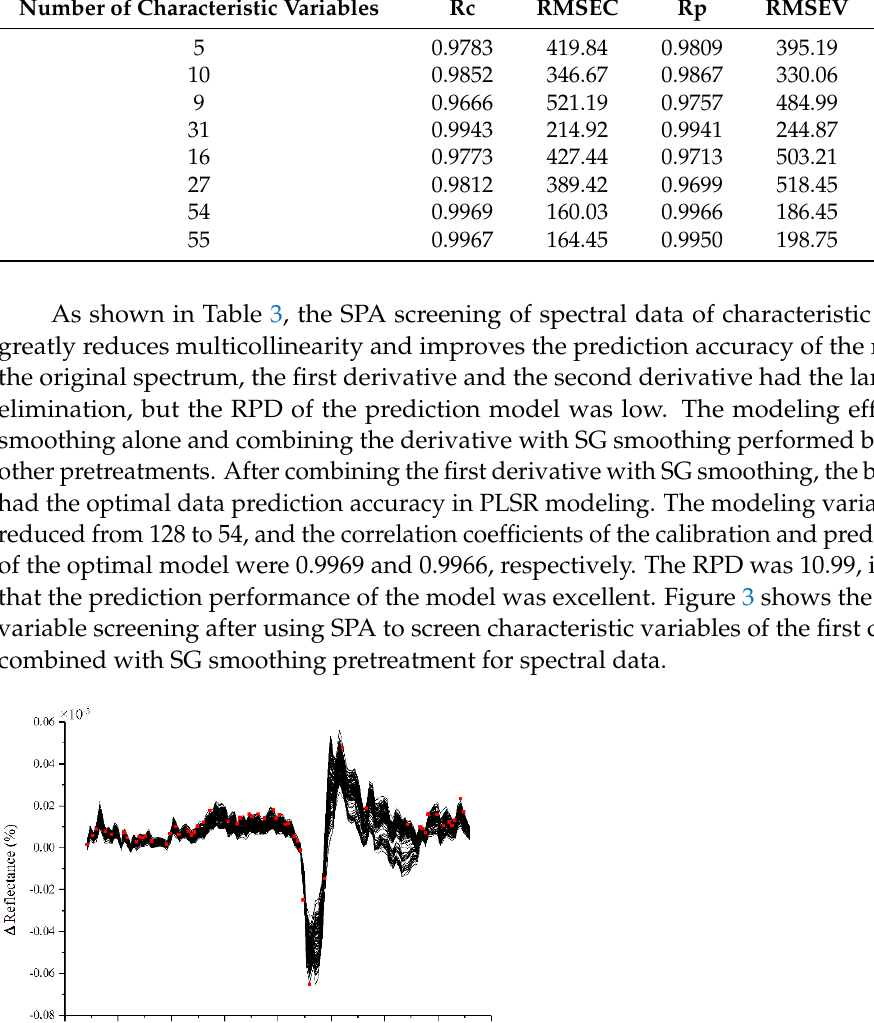
Table 4. Comparing PLSR results after extracting spectral features by a competitive adaptive re- weighted sampling algorithm.